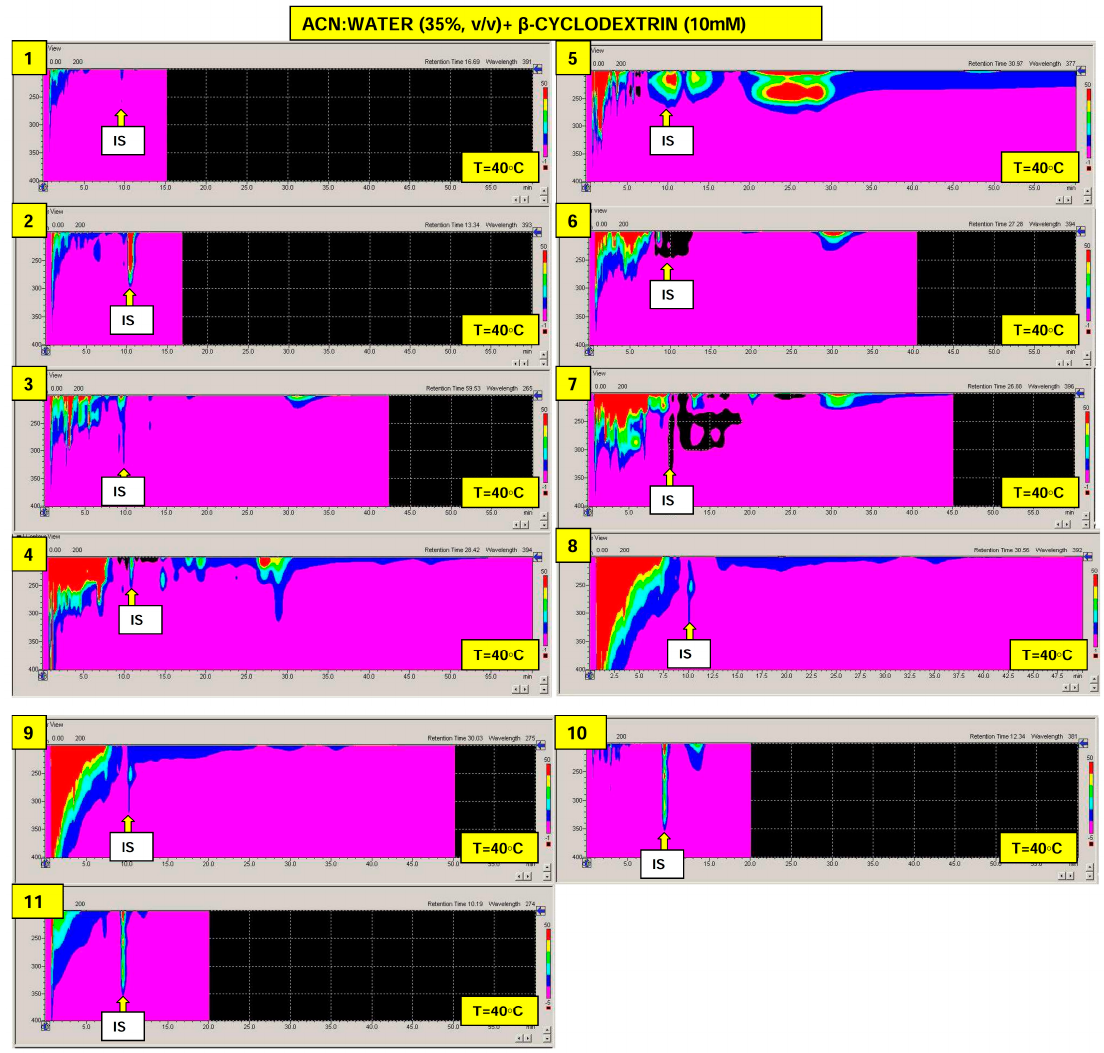
Figure 3. Typical DAD-UV-Vis chromatograms’ of samples investigated. Chromatograms labels: 1 . Boiledtap water, 2 . Rice bag, 3 . Plastic bag, 4 . Cloth, 5 . Fish baits, 6 . Sanitary towels, 7 . Wet wipes, 8 . Boiled purified sewage, 9 . Raw purified sewage, 10 . Distilled water, 11 . Raw tap water. Table 6. Quantitative data (values of peak heights and bisphenol A/internal standard ratio) for all samples investigated.